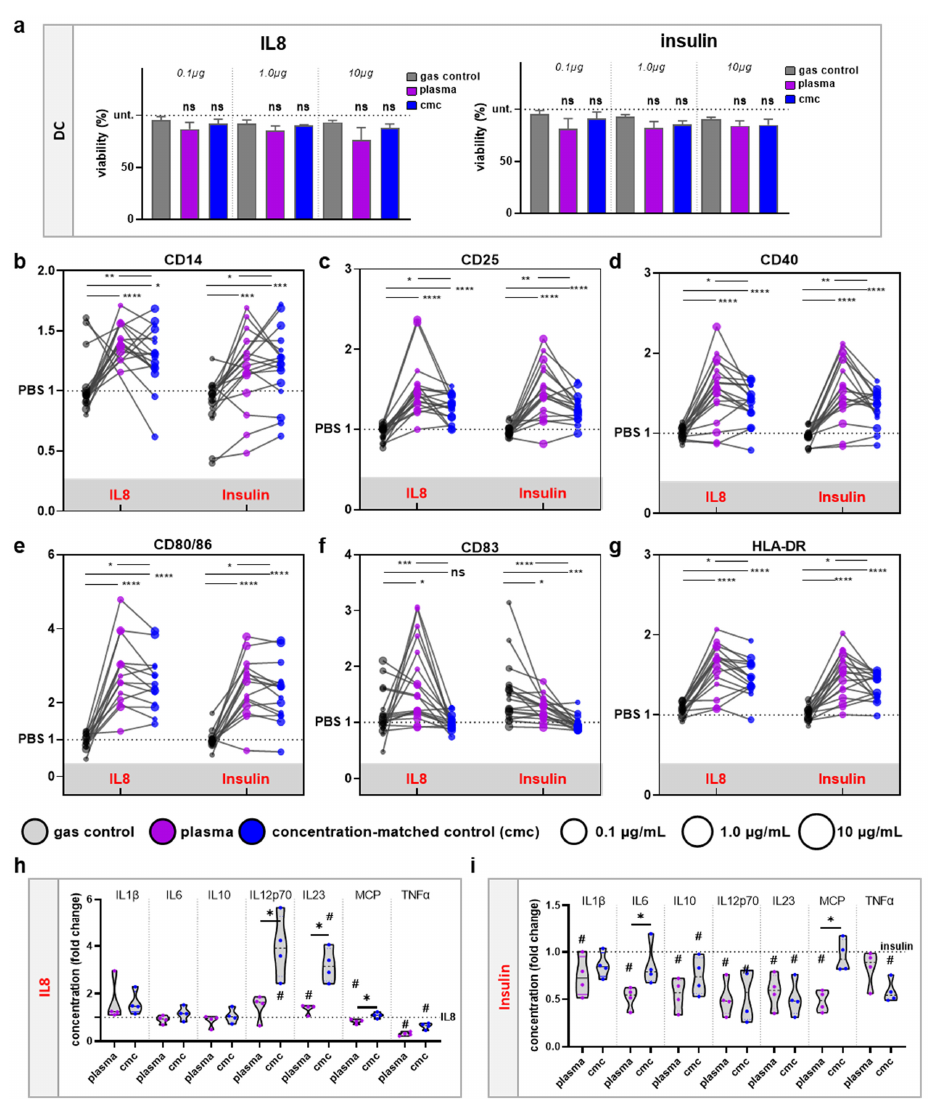
Figure 4. Oxidized IL8 and insulin stimulate moDC activation and suppress cytokine secretion. ( a ) Viability of human moDCs in response to native, gas plasma ‐ , or H 2 O 2 ‐ treated IL8 or insulin; ( b – g ) surface marker expression of CD14 ( b ), CD25 ( c ), CD40 ( d ), CD80/86 ( e ), CD83 ( f ), and HLA ‐ DR ( g ) in moDCs incubated with the proteins was investigated using flow cytometry; ( h , i ) secretion